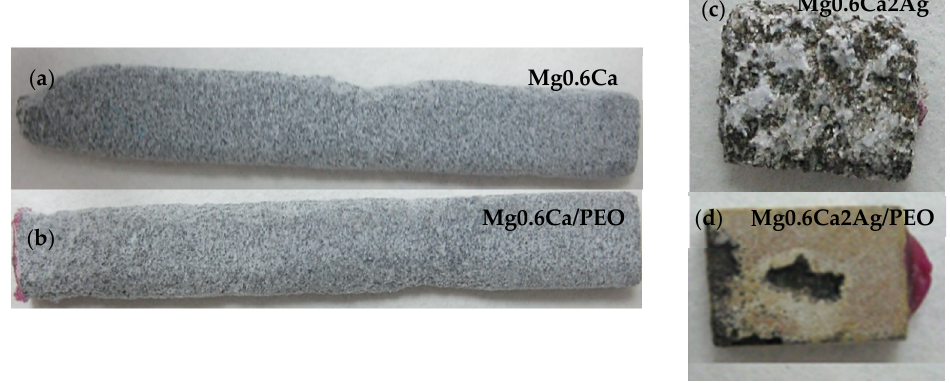
Figure 10. 3D macrograph of ( a ) Mg0.6Ca, ( b ) Mg0.6Ca/PEO after 60 days, ( c ) Mg0.6Ca2Ag and ( d ) Mg0.6Ca2Ag/PEO after 4 days of immersion in m-SBF.